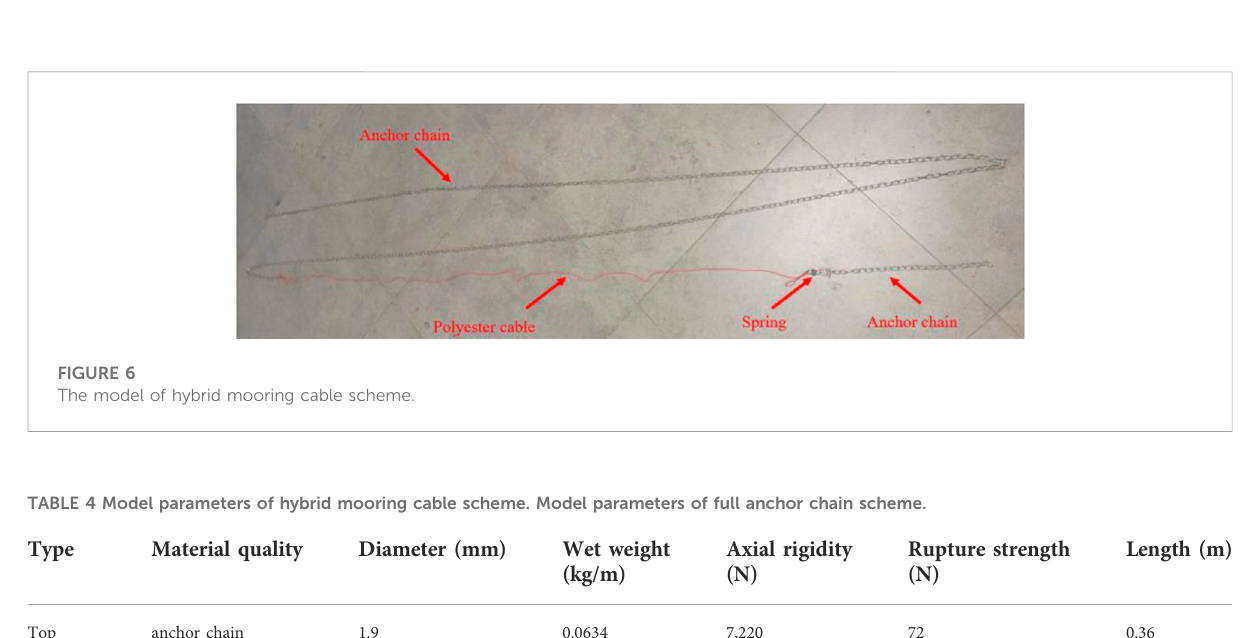
FIGURE 5 Diagram of connection scheme.